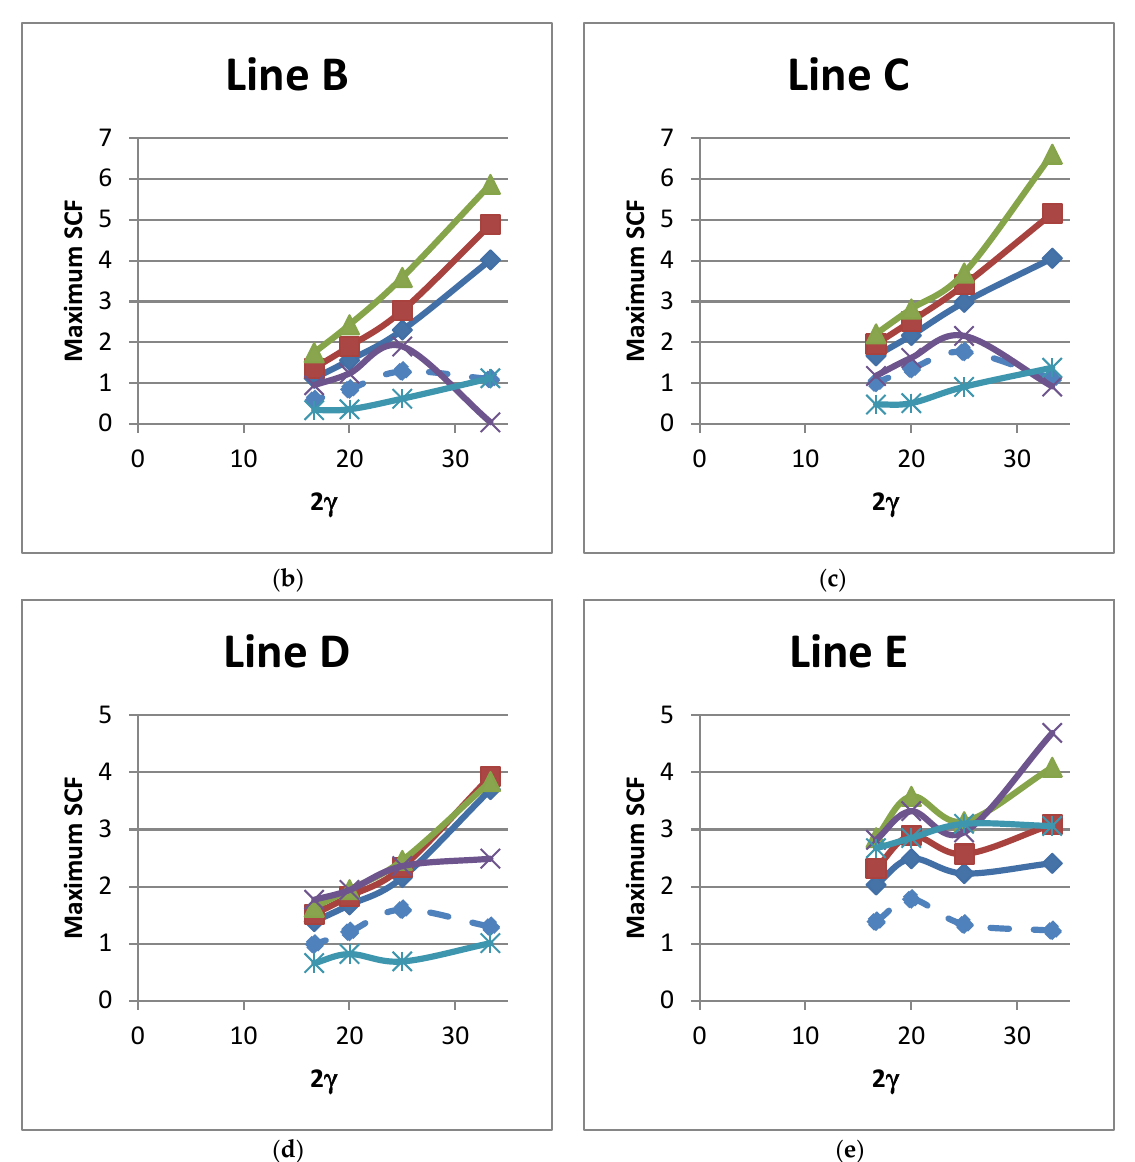
Figure 13. Influence of 2 γ on SCFs along lines: ( a ) A; ( b ) B; ( c ) C; ( d ) D; and ( e ) E.